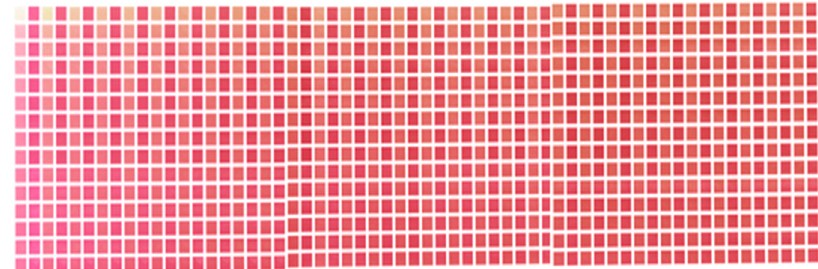
Figure 5. Color patches with two pigment layers and clear